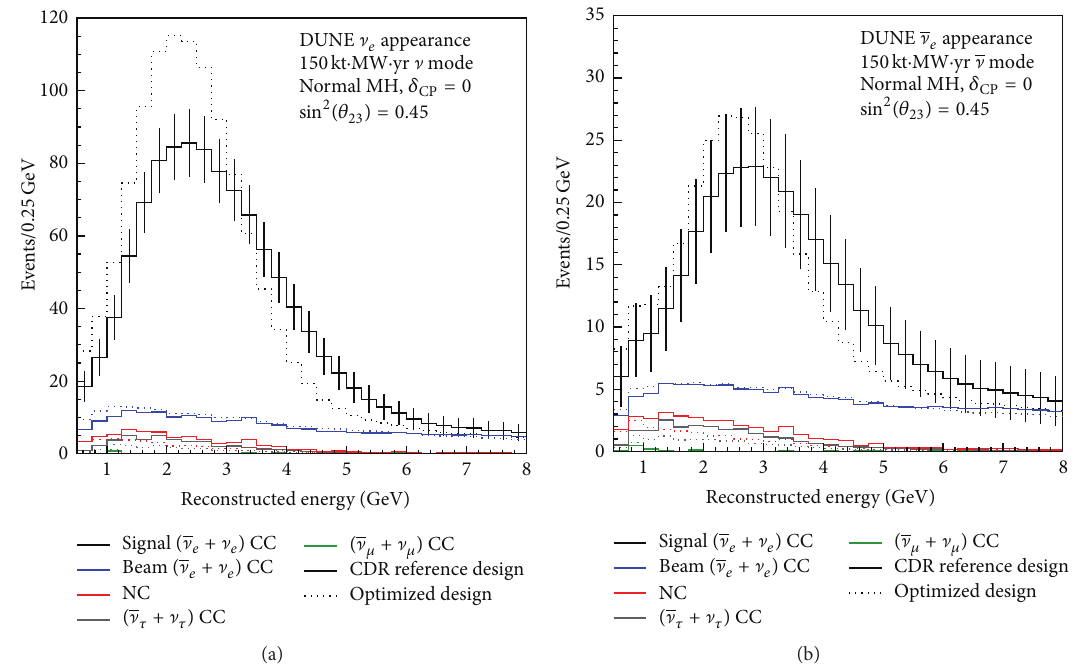
Figure 2: Reconstructed energy distributions of selected ] 𝜇 → ] 𝑒 and ] 𝜇 → ] 𝑒 appearance events for 150 kt ⋅ MW ⋅ yr exposure, assuming = 0 . Event rates and backgrounds are shown both for the reference design (solid) and for an optimized beam (dots) which has NO and 𝛿 CP been designed but not fully